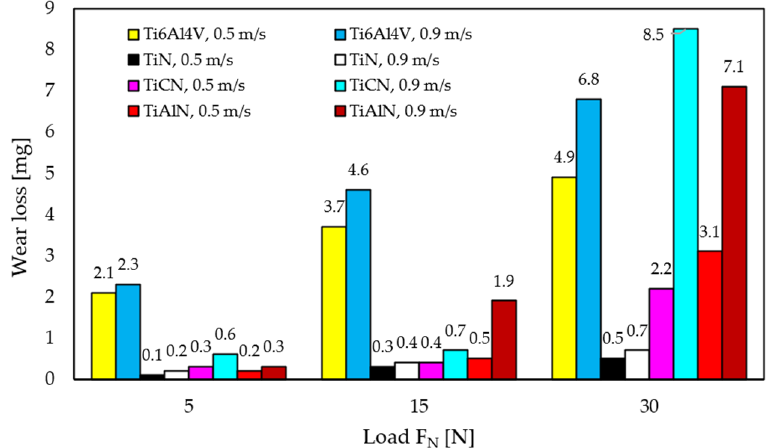
Figure 15. The variation in wear loss with load and sliding rate.